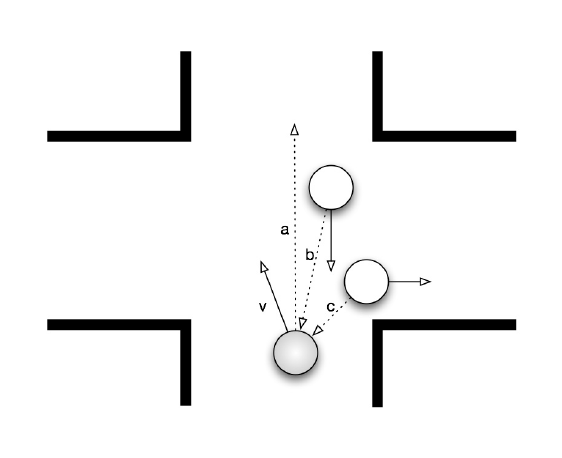
Figure 2. A diagram exemplifying an analytical model for pedestrian movement: the gray pedestrian, in the intersection, has an overall velocity v that is the result of an aggregation of the contributions related to the effects of attraction by its own reference point ( a ), and the repulsion by other pedestrians ( b ) and ( c